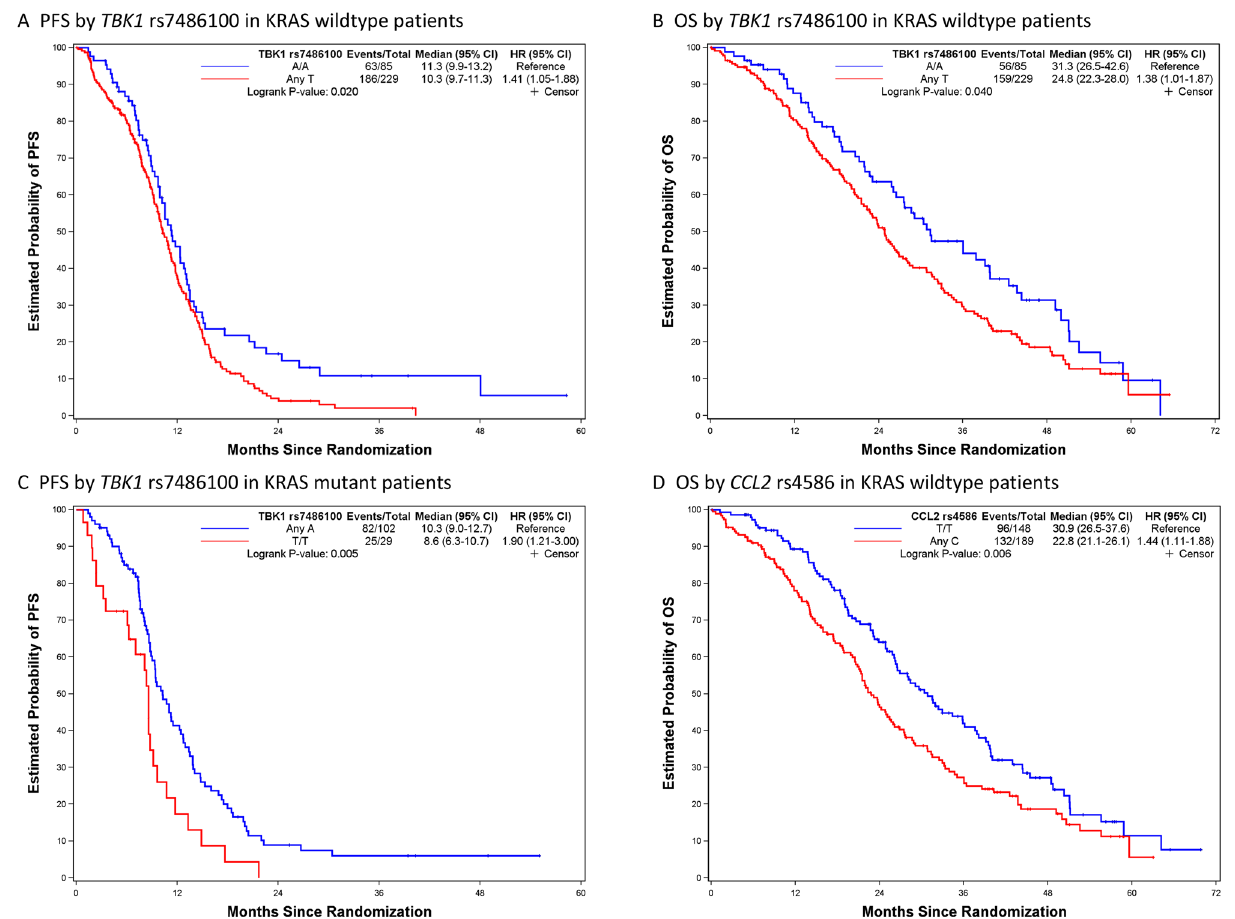
Figure 6. Kaplan–Meier curves and log-rank test for TAM pathway SNPs predictive of PFS and OS in KRAS wild-type and mutant mCRC patients: ( A ) KRAS wildtype patients with TBK1 rs7486100 A/A variant have longer PFS (11.3 vs. 10.3 mo; p = 0.020) and ( B ) OS (31.3 vs. 24.8 mo; p = 0.040) compared to those with Any T allele. ( C ) KRAS mutant patients with TBK1 rs7486100 A/A genotype also have longer PFS (10.3 vs. 8.6